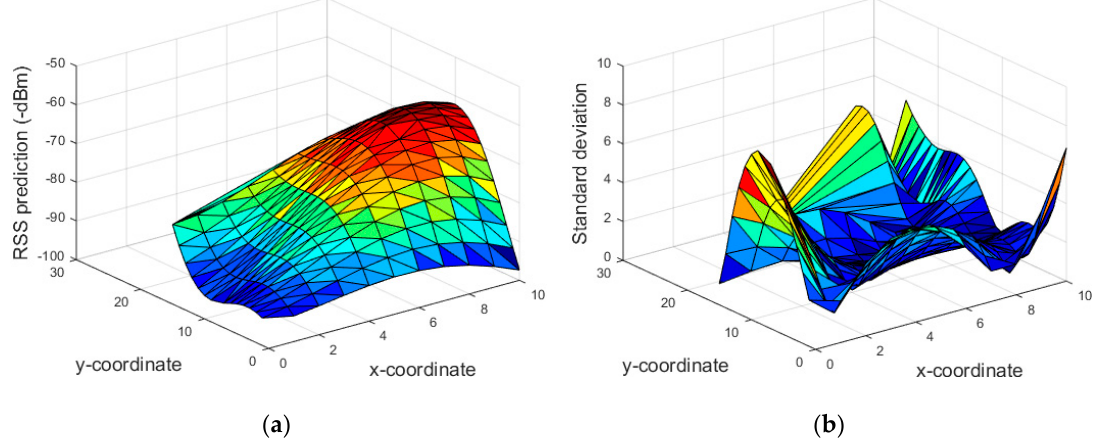
Figure 4. Surface plot of beacon 4 signal ( a ) predicted RSS, ( b ) corresponding standard deviation. After the GPR operation, the predicted mean RSS was fed to the APC for RSS clustering. While varying the damping factor ( γ )[ 0.5, 0.9 ] introduced in (15). The obtained clustering result is presented Sensors 2019 , 19 FOR PEER REVIEW in Figure 5.